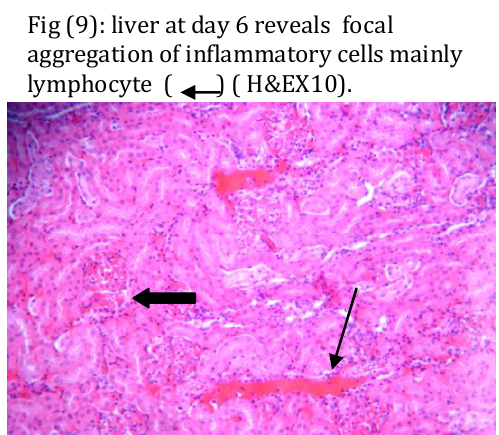
Fig (11): kidney at day 4 pi. revealed hemorrhage between renal tubules ( ), and lymphocytes infiltration in proximal renal tubules ( ) ( H&EX10).